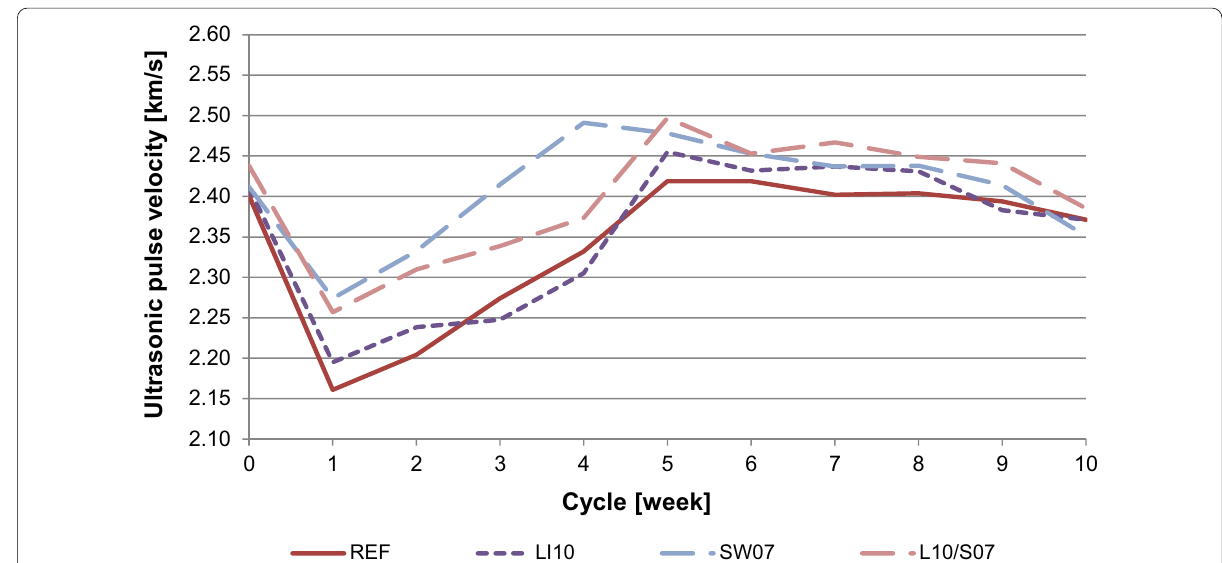
Fig. 15 Comparison of ultrasonic pulse velocity in cement-bonded particleboards exposed to wet–frost–dry cycles in accordance with